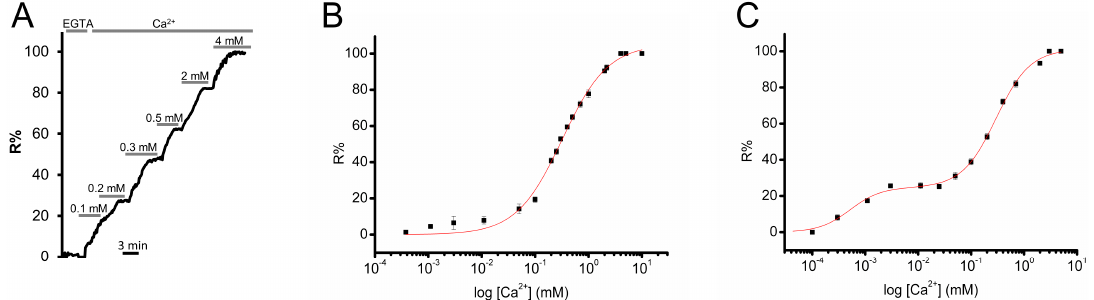
Figure 2. In situ calibration of the D4ER and D1ER probes. ( A ) Titration protocol. Representative kinetic of R% in permeabilized BHK cells transiently transfected with D4ER and exposed to different [Ca 2+ ] in the medium. After ER emptying by BK (100 nM) and CPA (20 µ M) application, cells were permeabilized with digitonin (20 µ M) and bathed with an intracellular-like medium without energy sources and containing the indicated [Ca 2+ ]; ( B ) in situ Ca 2+ titration R% values measured with D4ER, along with corresponding fits of the data. Mean ± s.e.m, N ≥ 6 cells for each [Ca 2+ ]; and ( C ) in situ Ca 2+ titration R% values measured with D1ER, along with corresponding fits of the data. Mean ± s.e.m, N ≥ 6 cells for each [Ca 2+ ].